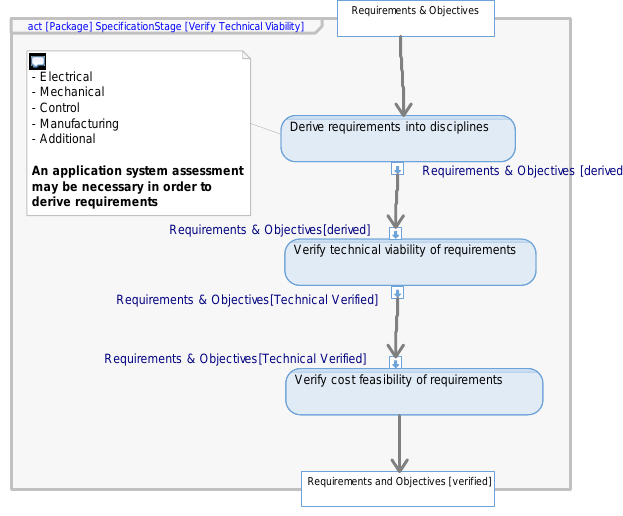
Figure 6. Verify technical viability activity.